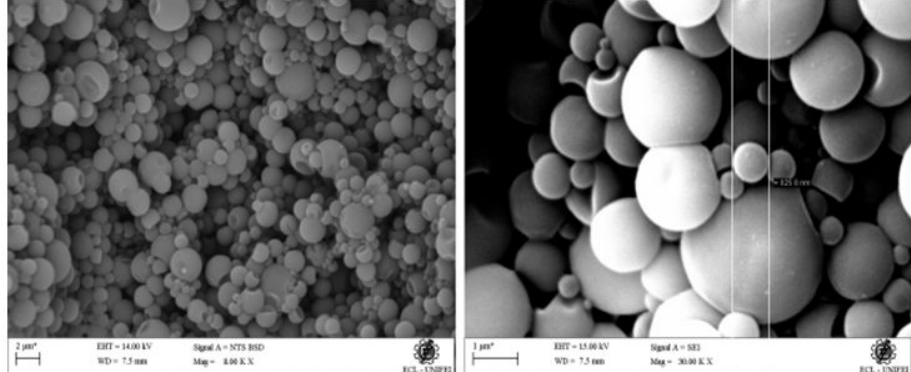
Figure 3. SEM images of CoHo:PGLyD microspheres at magnifications of 8 kX (left) and 30 kX (right), respectively. k=1,000.